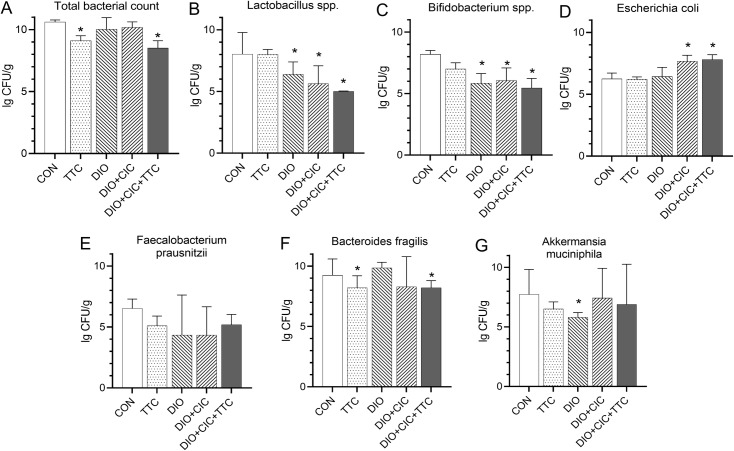
Effects of TTC on intestinal microbiota composition in healthy rats and obese rats with CIC.(A) Total bacterial count. (B) Lactobacillus spp., (C) Bifidobacterium spp., (D) E. coli, (E) Faecalibacterium prausnitzii, (F) Bacteroides fragilis, and (G) Akkermansia muciniphila counts in fecal samples were analyzed by RT-PCR. Results are presented as mean ± SD and expressed in CFU/g. * indicates p < 0.05 when data is compared to that for the CON group.